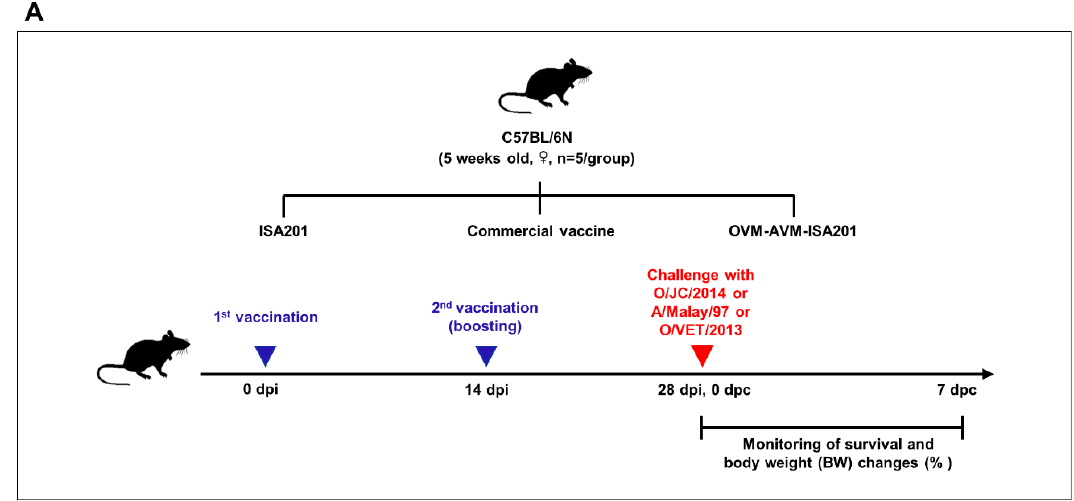
Figure 3. OVM-AVM-ISA201-mediated host defense against FMDV infection in mice. As the strat- egy depicted in Figure 3A, mice ( n = 5/group) were intramuscularly administered with 20 µg of OVM and 20 µg of AVM emulsified with ISA201. The positive control received (1/10 pig dose) com- mercial trivalent vaccine. The negative control received the same volume of ISA201. Vaccination was performed twice at a 14 day interval. Mice were challenged with 100 LD 50 of O/Jin- cheon/SKR/2014 (O/JC/2014), A/Malay/97, or O/Vietnam/GiaBình/2013 (O/VET/2013) at 28 days post immunization (dpi). The survival rate and body weight were monitored for 7 days post chal- lenge (dpc). ( A ) Schematic depiction of mouse experiment strategy. ( B ) Survival percentage. ( C ) Percentage of body weight changes after O/Jincheon/SKR/2014 challenge. ( D ) Survival percentage. ( E ) Percentage of body weight changes after challenge with A/Malay/97. ( F ) Survival